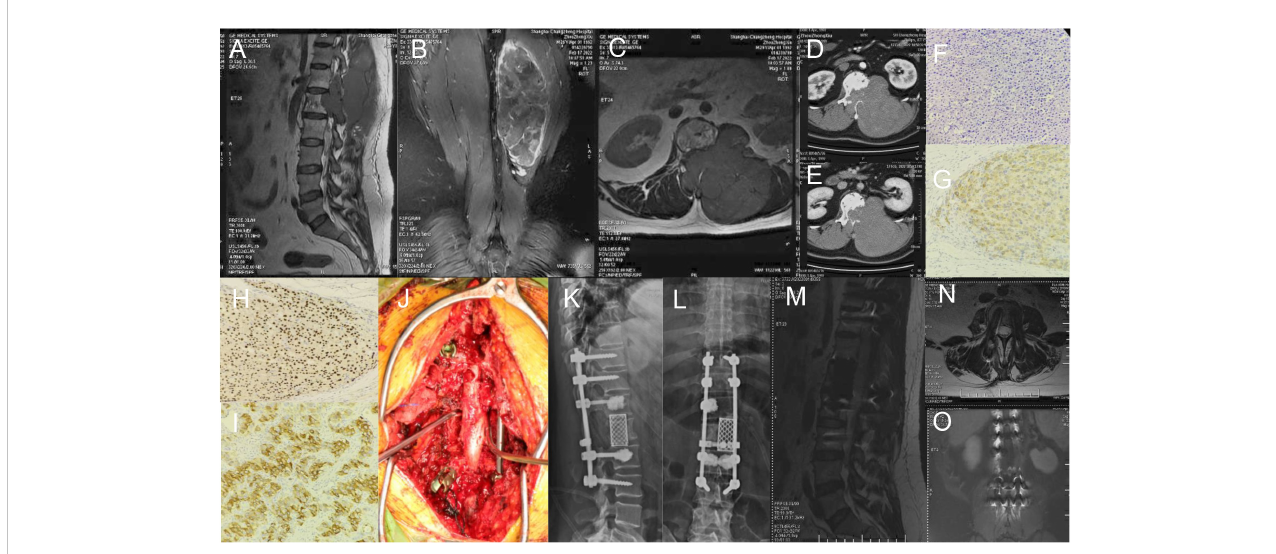
FIGURE 3 (A – C) Preoperative sagittal, coronal, and transverse MRI images of L1 vertebral body tumors; (D, E) Preoperative transverse CT scan showed L1 vertebral body tumors; (F) H&E staining of adrenocortical carcinoma; (G – I) Immunohistochemical stainings for Inhibin a, SF-1 and Syn; (J) She had a history of adrenal tumor (4 points). Visceral metastases were not detectable (0 point). Bone metastases were isolated (1 point). Her total prognostic score was 5 points. So, we chose the surgical strategy of total piecemeal resection. The tumor was excised by total piecemeal resection, pedicle screws, titanium mesh and titanium rods were used to reconstruct the stability; (K, L) Postoperative X-ray; (M – O) Postoperative sagittal, transverse, and coronal